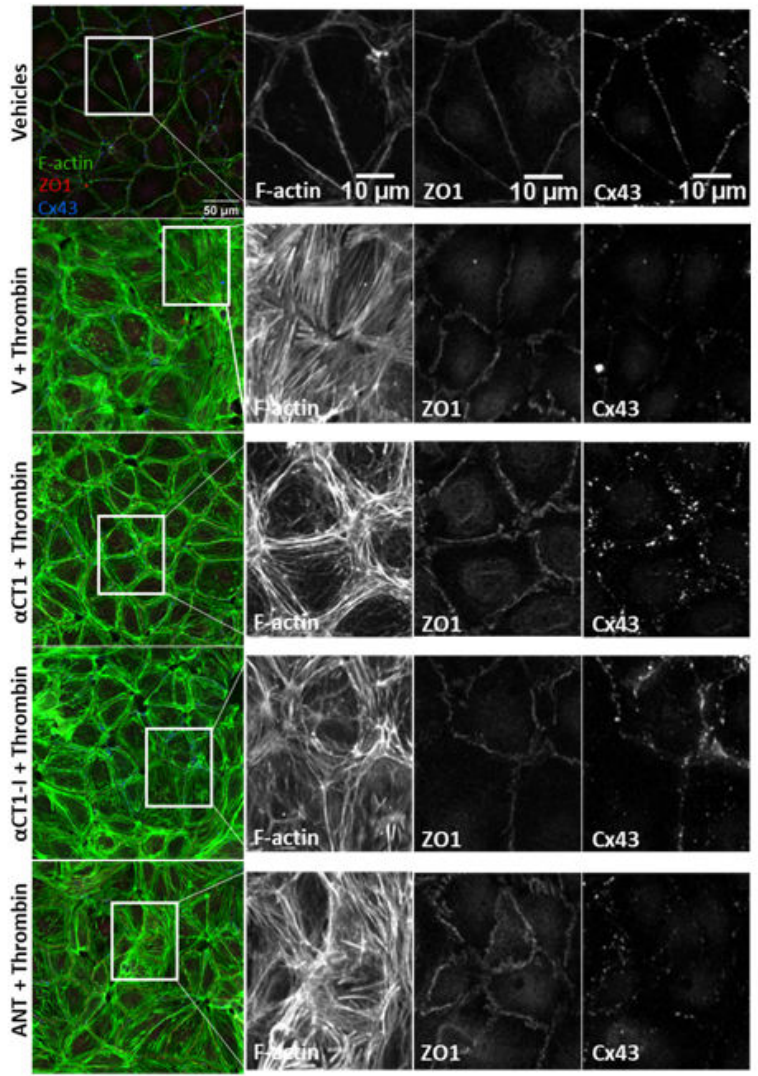
Figure 7. α CT1 inhibits thrombin-induced shift in endothelial F-actin distribution in association with ZO1 and Cx43 remodeling in HDMEC monolayers. Representative confocal images of F-actin cytoskeleton, Cx43, and ZO1 distribution in 100 µ M peptide-treated, Transwell filter-grown HDMECs, fixed 10 min after thrombin addition to the media. Black and white zoomed images show treatment- induced changes in more detail at the level of cell–cell